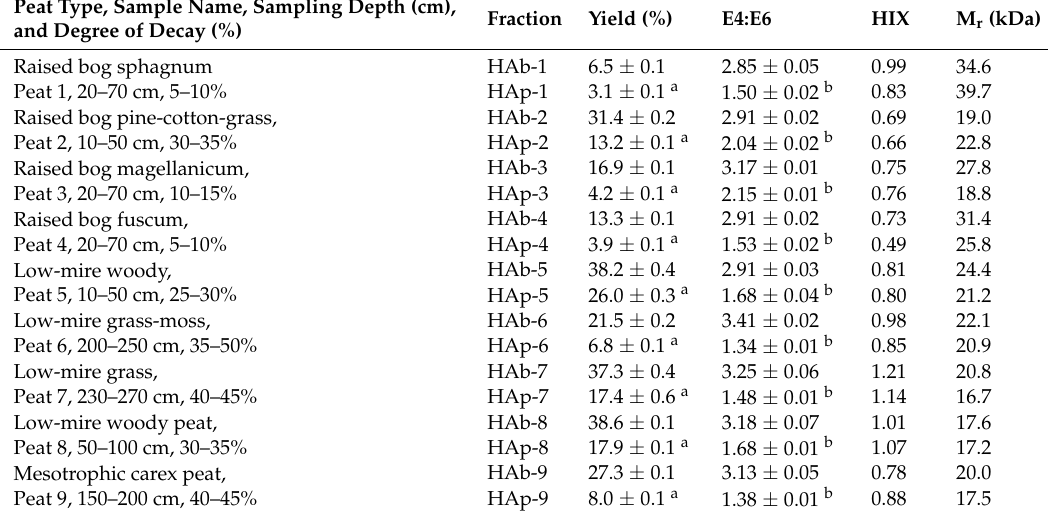
Table 1. Characterization of the peat samples, yields of HA fractions isolated by basic and pyrophosphate extraction from the peat samples, and selected physicochemical